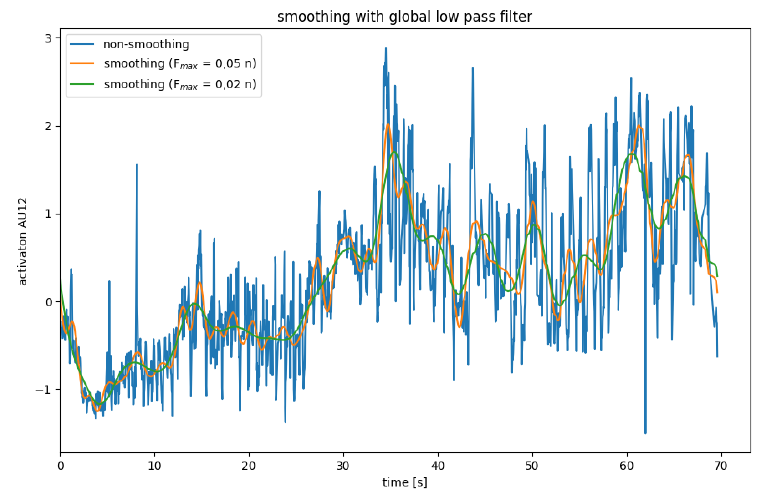
Figure 5. AU smoothing with average mean with binomial filter.